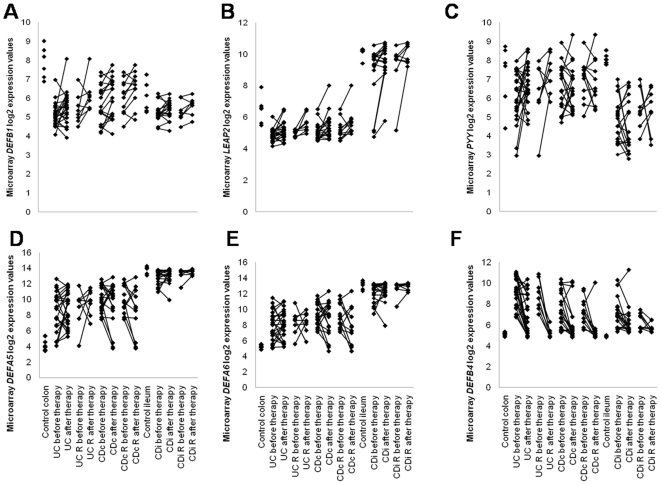
Individual microarray log2 expression values for selected AMP genes in intestinal mucosa of IBD patients before and after infliximab treatment and controls.(A) DEFB1 (probe set 210397_at), (B) LEAP2 (probe set 1552362_a_at), (C) PYY (probe set 207080_s_at), (D) DEFA5 (probe set 207529_at), (E) DEFA6 (probe set 207814_at) and (F) DEFB4 (probe set 207356_at). Lines between 2 points represent the change in expression before and after treatment for one patient. R: responders.